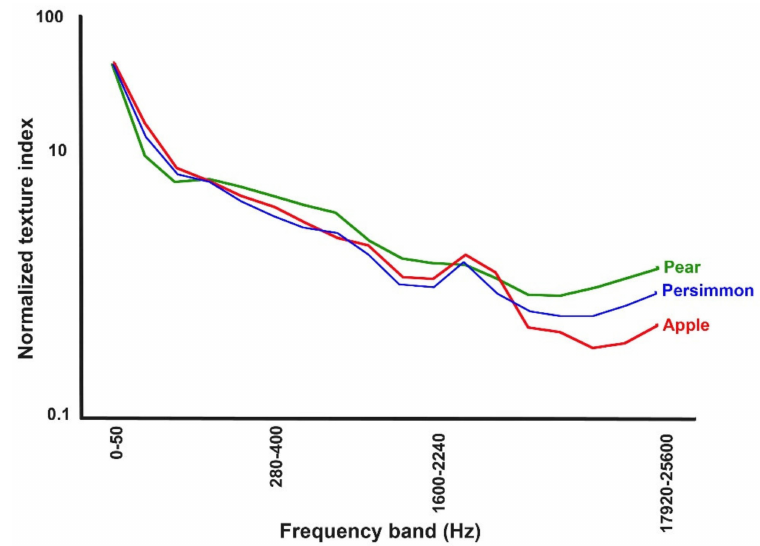
Figure 10. Calculated texture indices for apples, persimmons and pears with texture index versus frequency (modified from